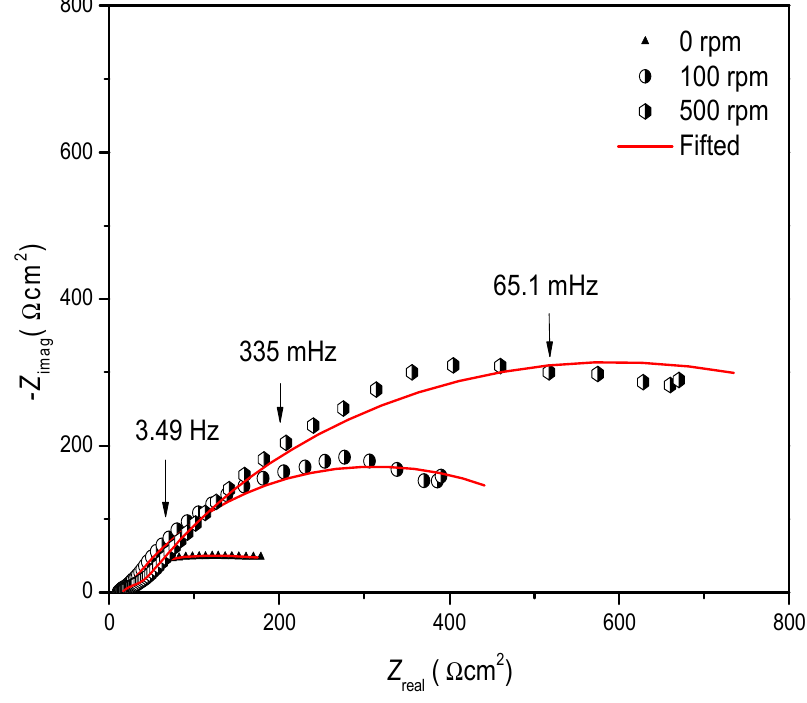
Figure 7. Examples of Nyquist plots of 10 ppm of 4-PC at different rotation rates.